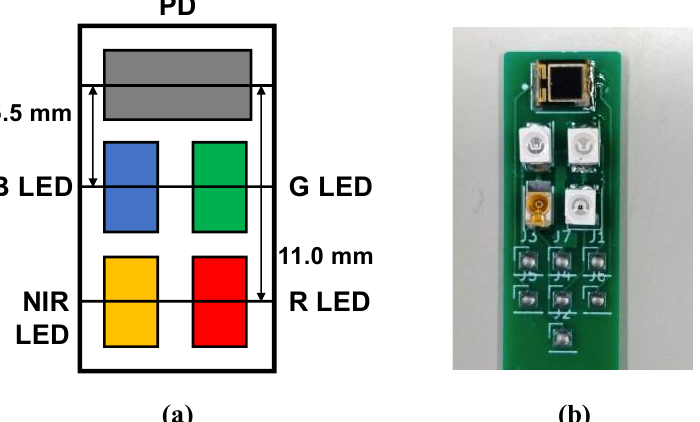
Figure 1. Developed multiwavelength photoplethysmogram (PPG) sensor: ( a ) layout of light-emitting diodes (LEDs) and photodiode (PD). B LED = blue LED (470 nm), G LED = green LED (528 nm), R LED = red LED (620 nm), and NIR LED = near-infrared LED (870 nm); ( b ) actual PPG sensor.